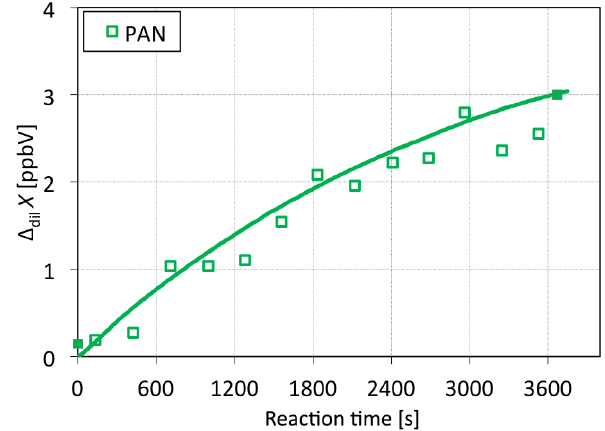
Figure 6. Dilution-corrected molar excess mixing ratios of O 3 , NO, NO 2 , and NO z ( = NO y -NO-NO 2 ) during 1h of plume evolution (in 1km bins). Point symbols refer to the measured data; solid lines represent the output of the UWCM based on MCM v3.3 chemistry.